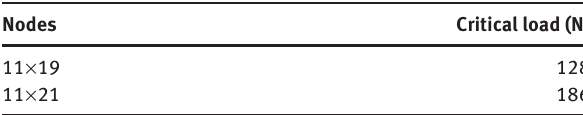
Kevlar/epoxy laminate. s